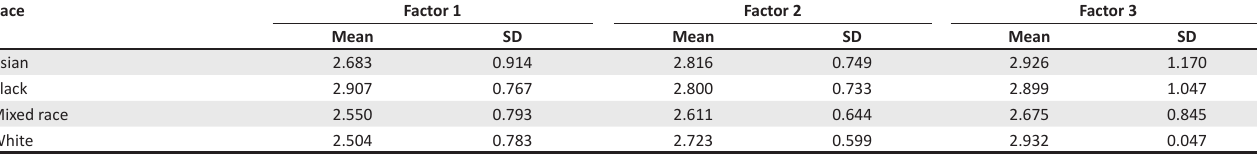
TABLE 12: Descriptive statistics for race groupings.